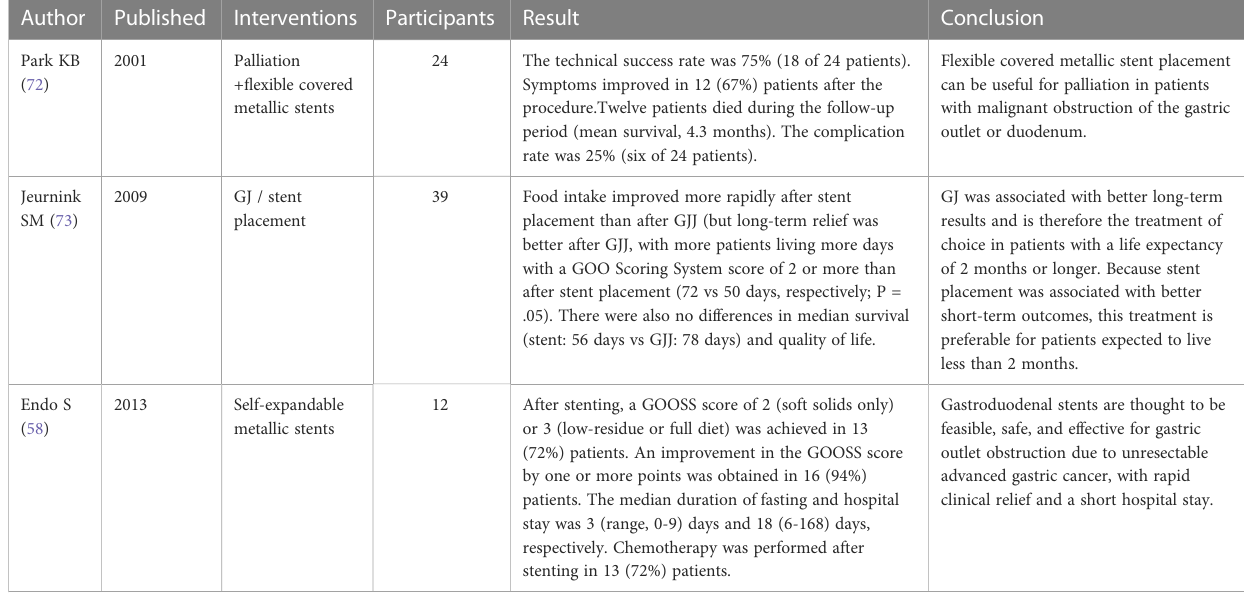
TABLE 3 Recent clinical trials of endoscopic stent placement on palliative treatment of advanced